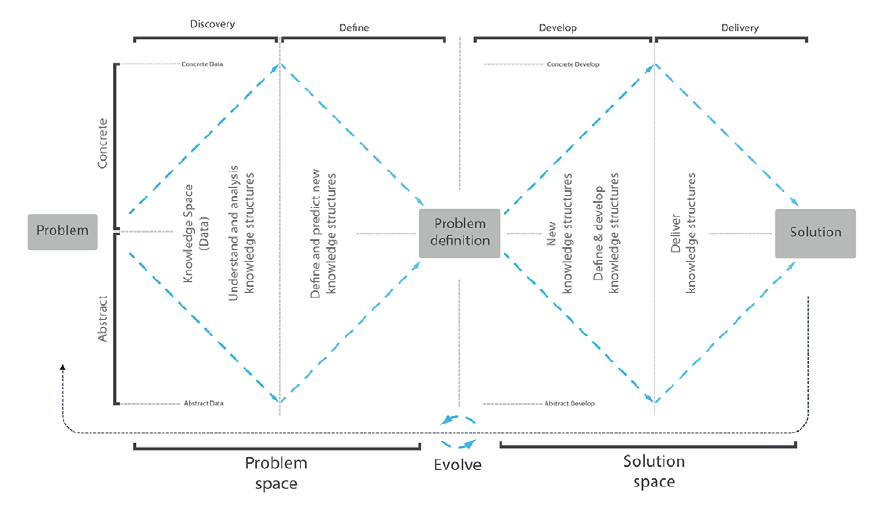
Figure 3. Data-driven design model process (source: created by